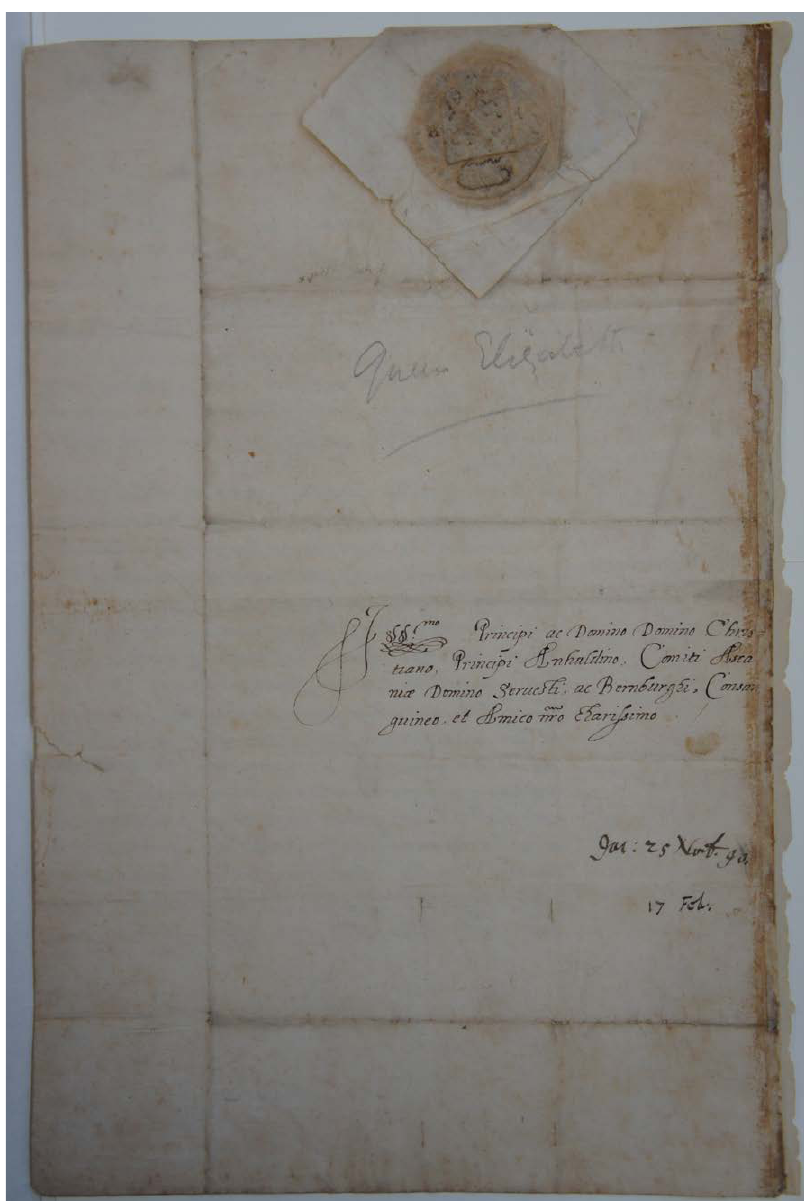
Fig. 2b – Latin letter penned by scribe ‘B’ and signed by Elizabeth (verso, showing the signet